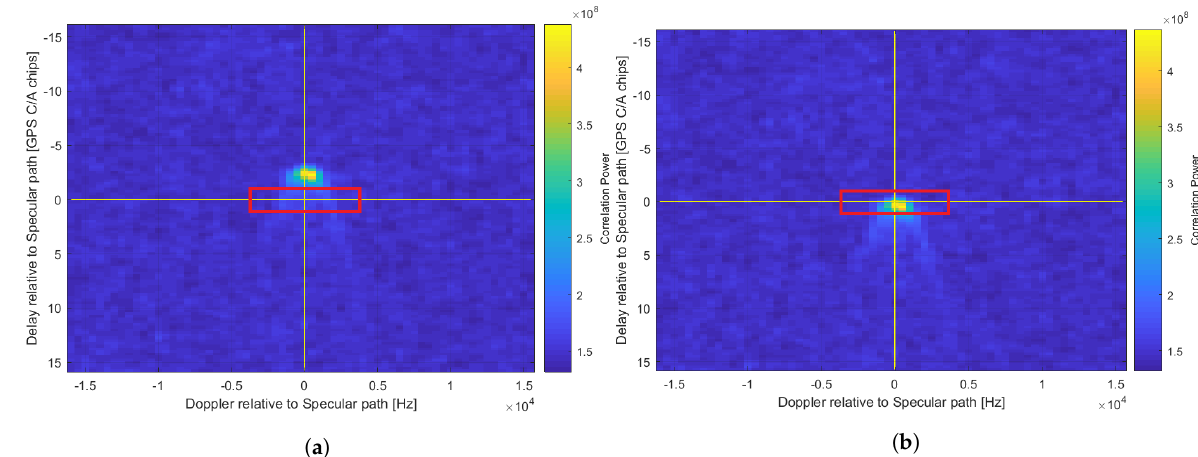
Figure 3. These DDMs demonstrate the impact of topography on the DDM and the impact of compressing the DDM using windowing. The red box represents an 8 × 8 pixel window. In this case, without the topography algorithm the peak power data would be lost as it falls outside the window. The surface elevation where this DDM was collected was approximately 400 m. ( a ) Land DDM generated with quasi-spherical algorithm. ( b ) The same DDM generated with the topography